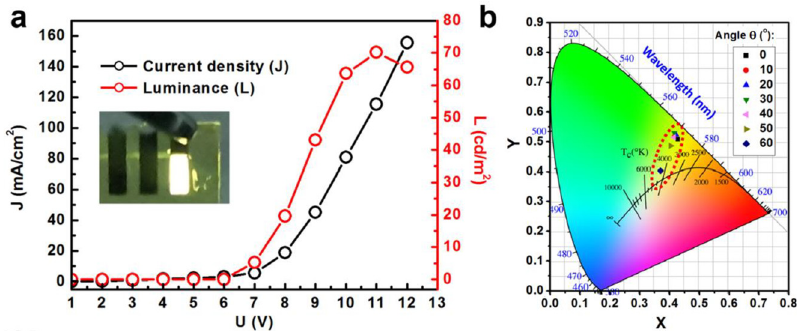
Figure 4: (a) Measurements of the J-V/L-V curves. Inset: photograph of the OLED device. (b) The dispersion map with CIE coordinates of the nano OLED